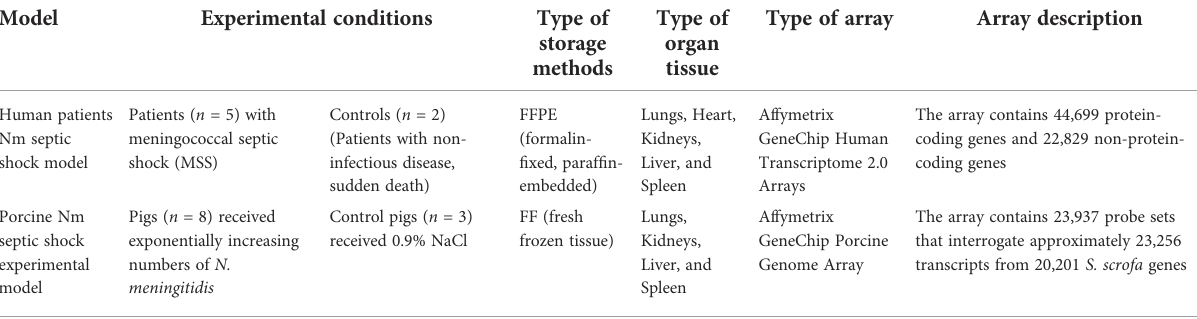
TABLE 1 Experimental conditions for DNA microarray